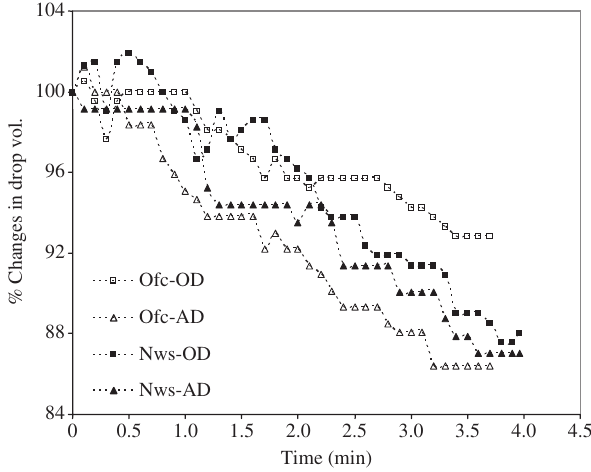
Figure 4: Effects of drying on drop volume changes (samples con- taining 1.5% AKD).